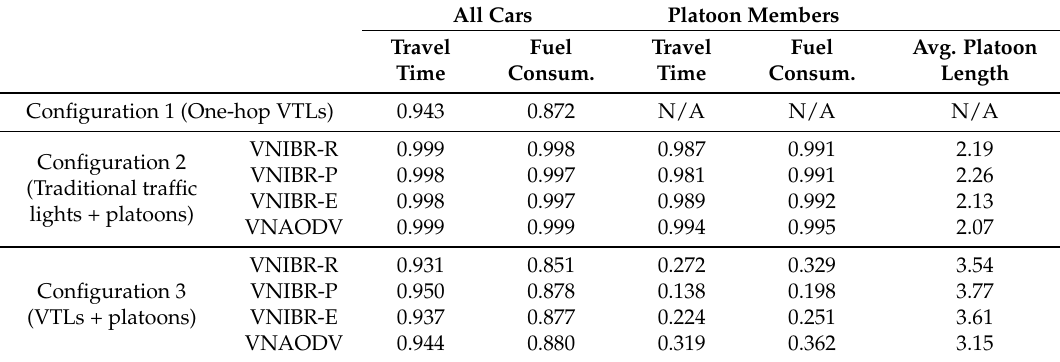
Table 3. Results for high traffic density (time and fuel normalized regarding best average values from configuration